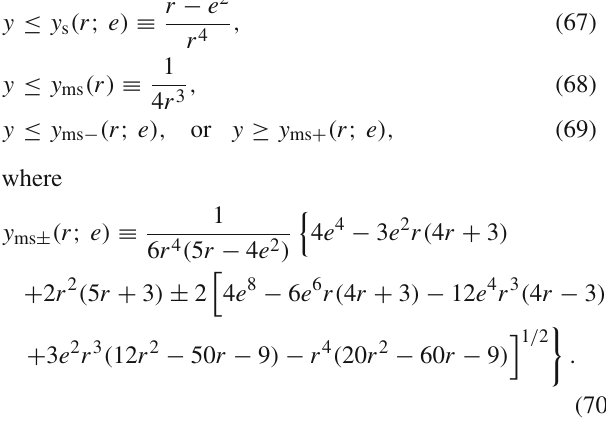
Regions, where functions a